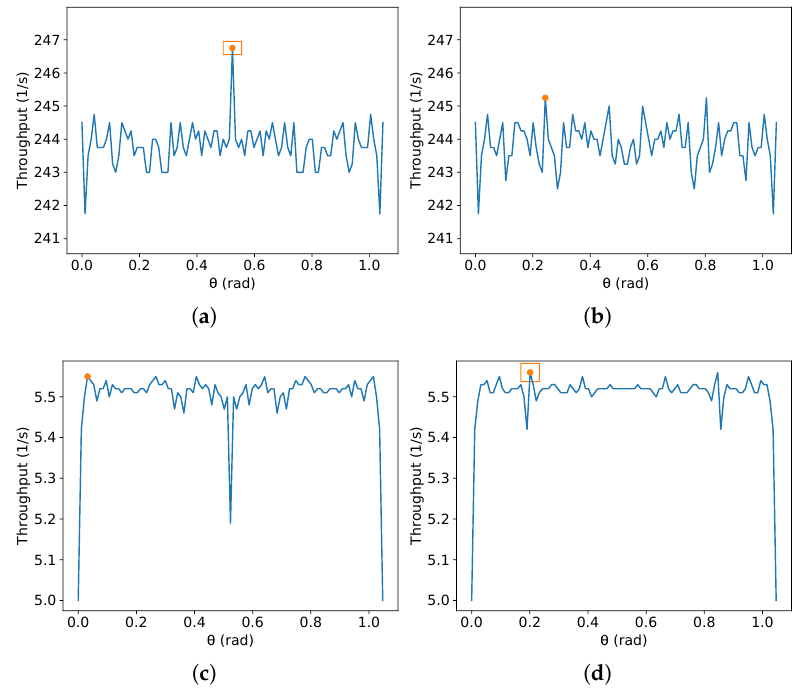
Figure 9. Continuation of Figure 8: examples of (9) varying θ from 0 to π generated values of T , s and d . ( a ) For 99 samples, T = 4 s, s = 2 m and d = 0.13 m. ( b ) For 100 samples, T = 4 s, s = 2 m and d = 0.13 m. ( c ) For 99 samples, T = 100 s, s = 2.40513 m and d = 1 m. ( d ) For 100 samples, T = 100 s, s = 2.40513 m and d = 1